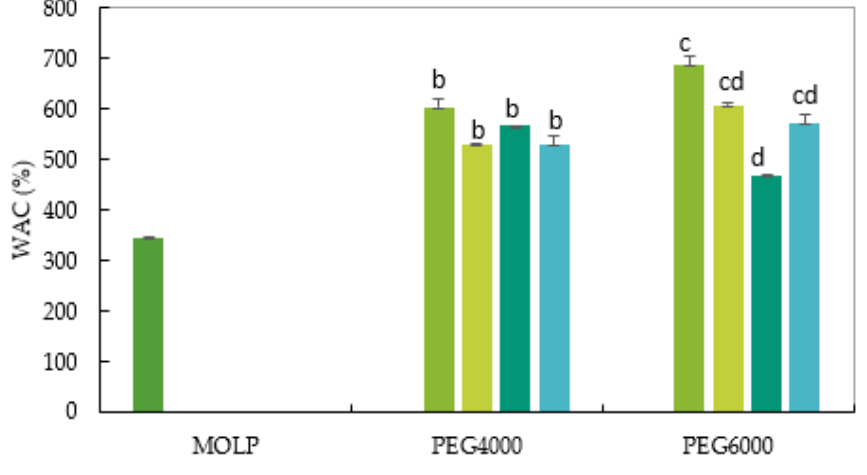
Figure 2. The water absorption capacity of MOLP and solid-dispersed MOLP prepared by melting, freeze-drying, solvent evaporation, and microwave methods using PEG4000 and PEG600 carriers. Bars with different superscripts in the same category (PEG) were significantly different ( p < 0.05).